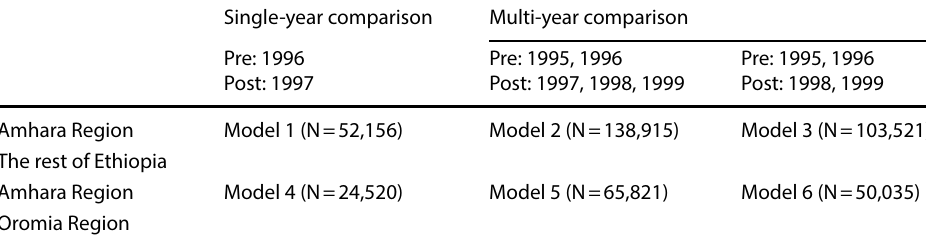
Table 2 Categories and sample size of DiD estimation